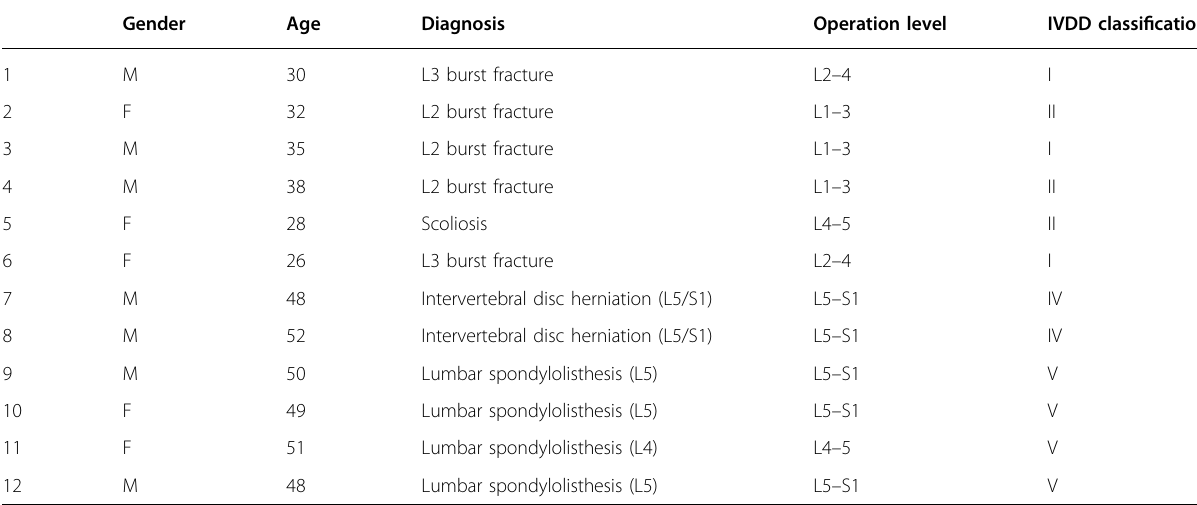
Table 1 Selected patient characteristics